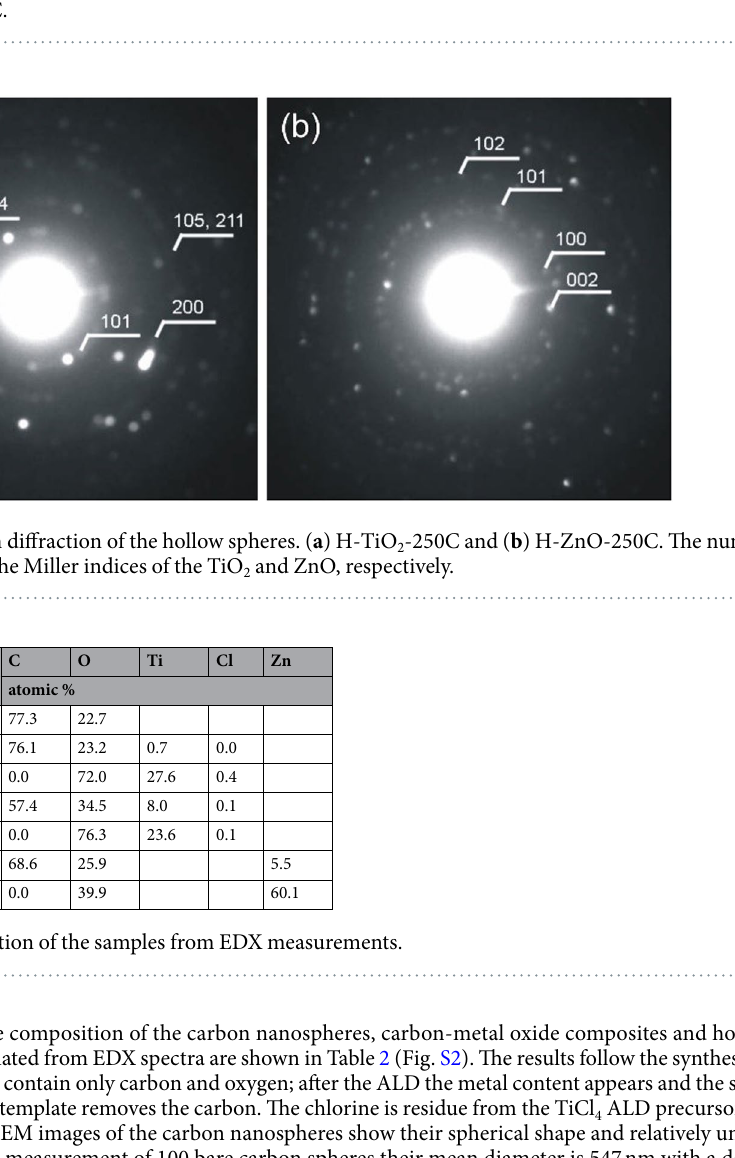
Figure 4. XRD diffractograms of the specimens. The diffractograms of the bare CNSs, the composites and the hollow nanospheres are shown with ( a ) TiO 2 deposited at 80 °C, ( b ) TiO 2 deposited at 250 °C and ( c ) ZnO deposited at 250 °C.